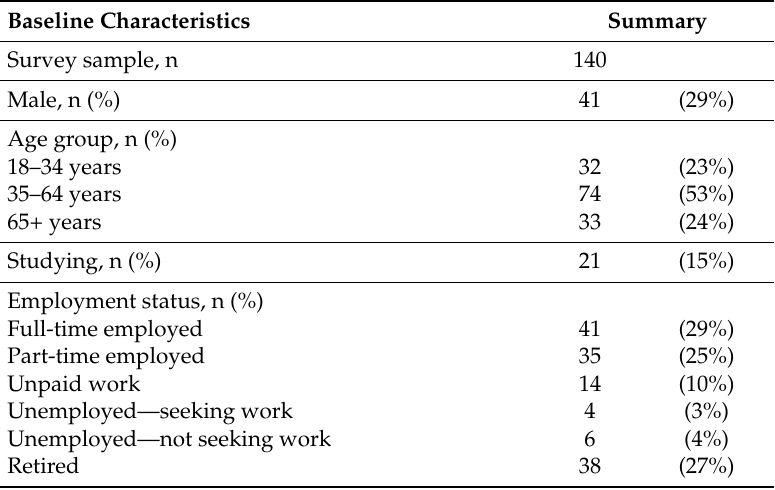
Table 1. Background characteristics of survey